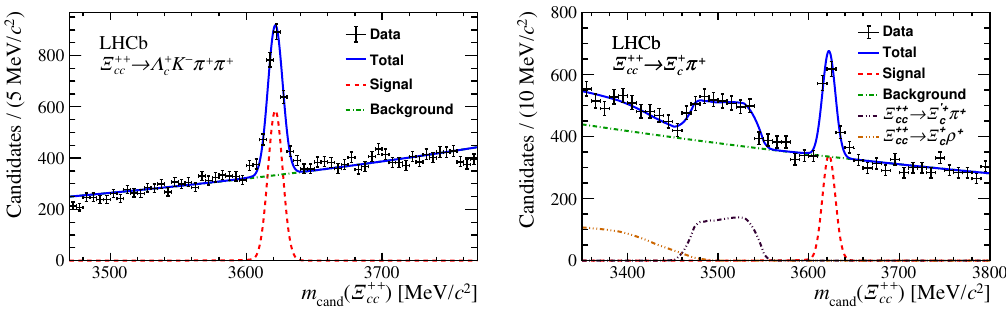
Figure 1 . Invariant-mass distributions of (left) (cid:4) ++ decay candidates, in the mass range of 3470{3770 MeV/ c 2 and 3350{3800 MeV/ c 2 , respectively. The results of unbinned extended maximum-likelihood (cid:12)ts to the mass distributions are indicated by the blue solid